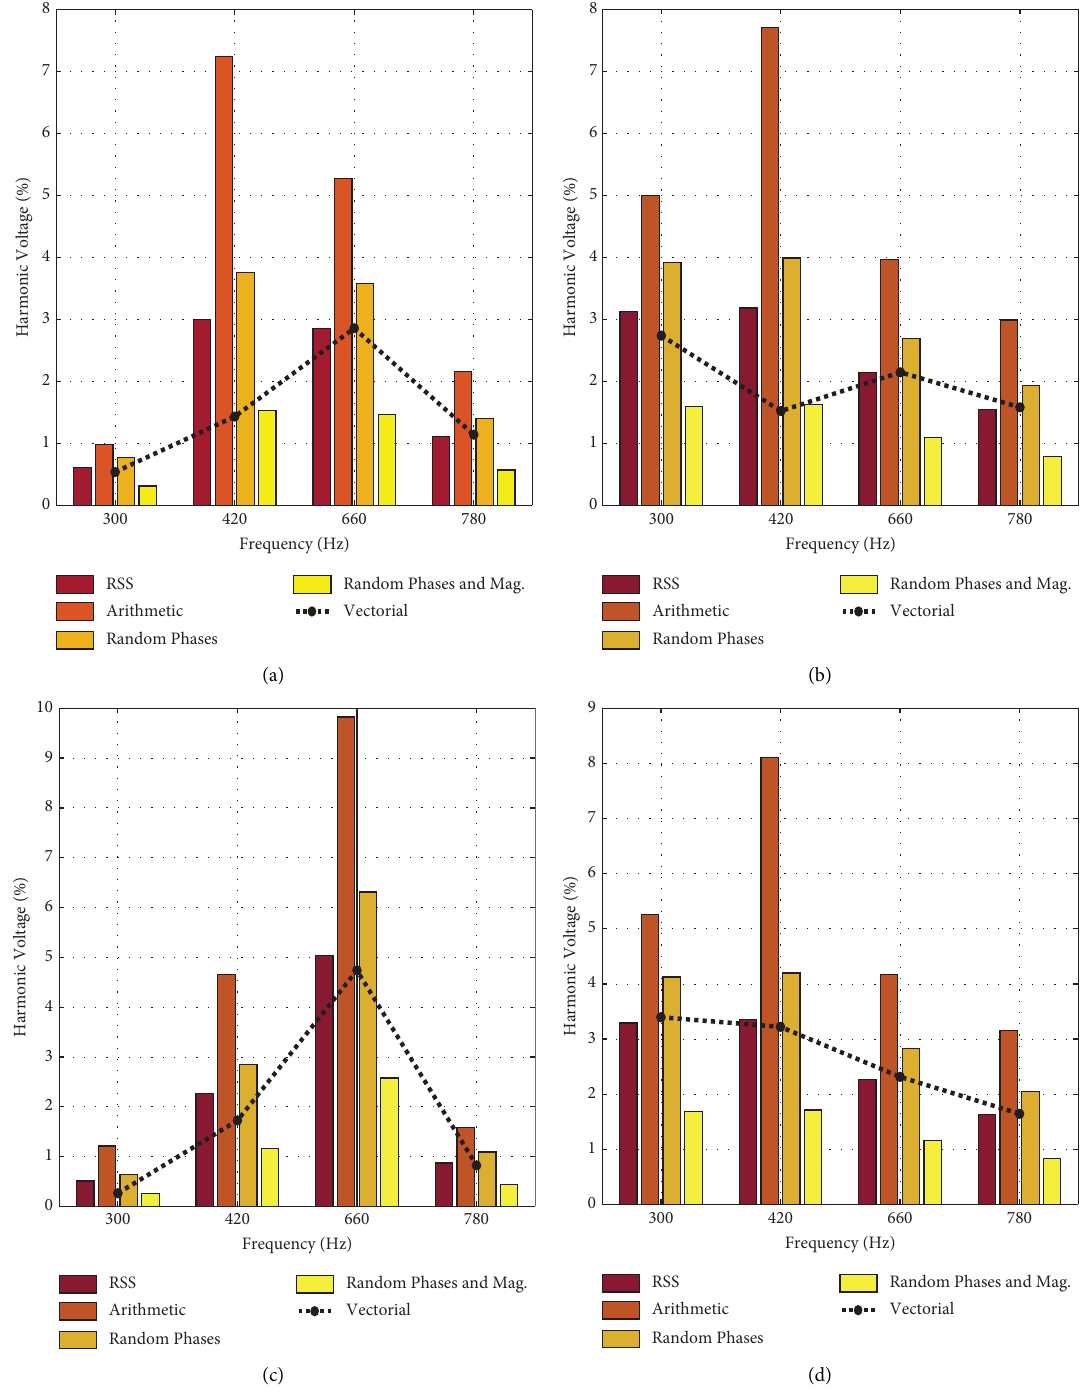
Figure 11: Summation results for Case 3 at busbar 4 (a) and busbar 5 (b), and Case 4 at busbar 4 (c) and busbar 5